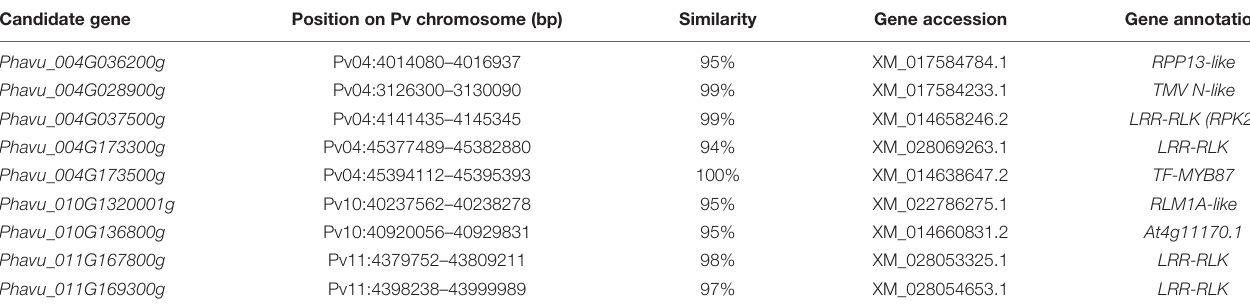
TABLE 3 | Identified positional candidate genes linked to powdery mildew disease resistance in common bean. Candidate gene Position on Pv chromosome (bp) Similarity Gene accession Gene